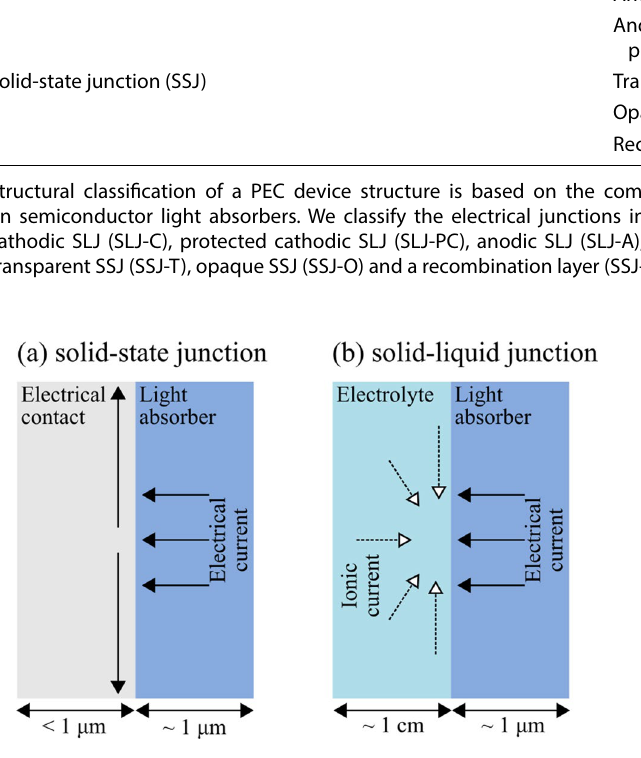
Fig. 1 Electrical junctions on a solid semiconductor. Photo-generated charge carriers can be extracted through either a SSJ or b SLJ. a The extraction through the SSJ requires an electrical current flow along the lateral direction across the large surface of the light absorber. b At the SLJ the electrical current through a solid contact is replaced with an ionic current through the electrolyte, which therefore reduces the transport distance to be no more than the thickness of the light absorber. The direction and distance of the ionic current are tunable by the design of a PEC